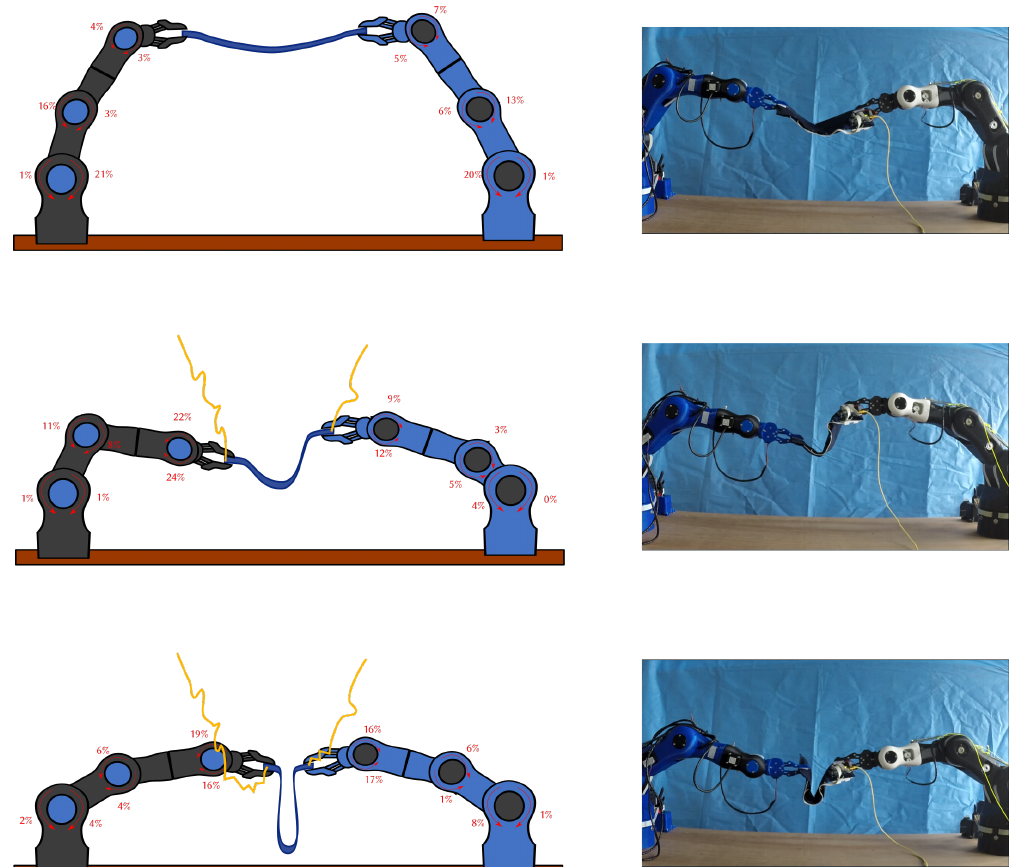
Figure 7. Demonstration of a folding trajectory of the learned policy broken down into three steps: start, middle and end of the episode. The robot state on the figure is visible from the stance of the robot arms. The action probabilities are given in red next to each joint. The executed trajectory is shown with a yellow